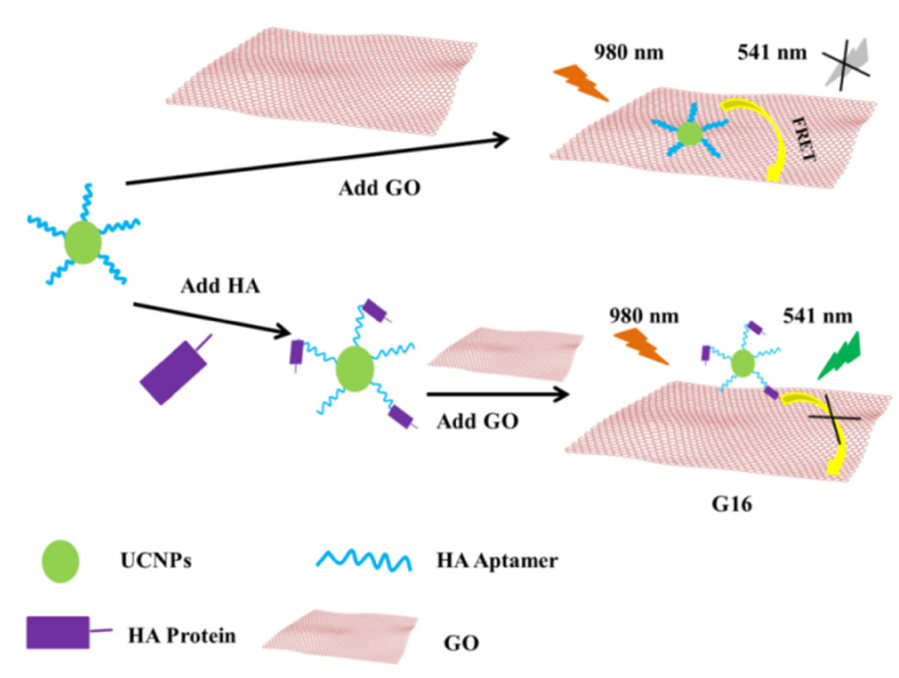
Figure 18. Schematic representation of UCNPs ( G16 ) and their sensing of HA of influenza via the FRET process. Reprinted from [73] with permission from the American Chemical Society.